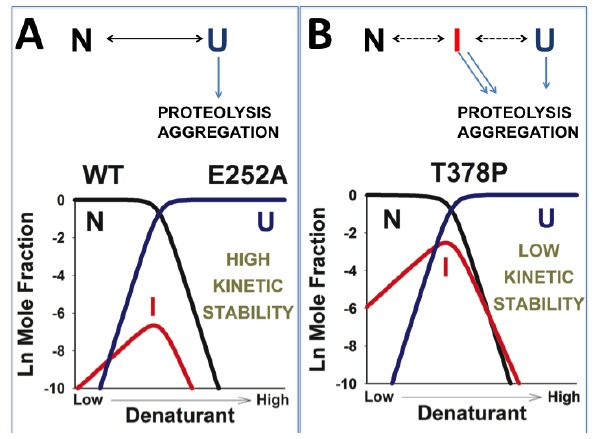
Figure 4. Plausible mechanisms linking the reduced kinetic stability (towards aggregation or proteolysis) and the lower unfolding cooperativity in disease-causing hPGK1 mutants. In the case of kinetically stable variants (panel A ), the levels of the highly kinetically sensitive intermediate (I) levels are always very low, and aggregation and proteolysis occur mainly through the unfolded state U (left side of the figure). However, in some mutants (panel B ), the population of the intermediate may raise (and can be “detected” by a low m -value in urea denaturations), leading to a significant contribution from the I state to the irreversible denaturation kinetics. It must be also noted that in panel B, at low denaturing stress, the I state is much more populated than the U state, and thus, may contribute much more to the kinetics of proteolysis and/or aggregation than the U